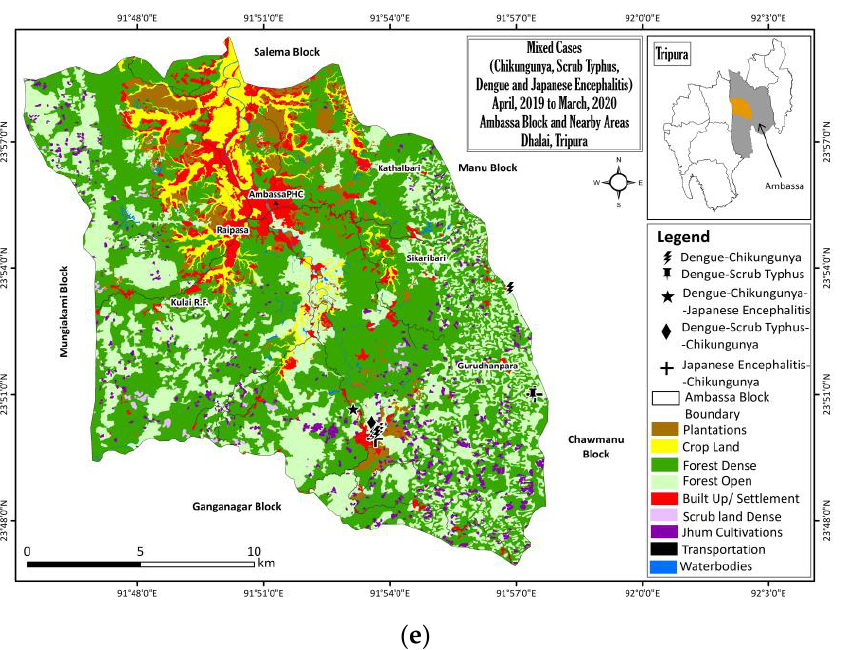
Figure 4. Land Use Land Cover (LULC) Maps of Ambassa Block. LULC mapping was prepared using the orthorectified Indian Remote Sensing satellite data, Cartosat-1 (2.5 m) and LISS-IV (5.8 m), employing on-screen visual interpretation techniques in the GIS platform. Field verifications were made by the project team to check for the accuracy of the interpreted data. Geolocations of village sample collection and NMVBD positive households were collected from the census and plotted on the map for analyses of the proximity of the households to the Jhum fields/plantations/forests, etc. Positive cases found from the PHC IPD collection were plotted for their village address. Geolocations of ( a ) all sample collection households from villages, ( b ) Dengue positive households, ( c ) Chikungunya households, ( d ) Japanese encephalitis and Scrub Typhus households, and ( e ) mixed infection case household locations from village and PHC based surveillance. Maps show the villages located mainly inside or nearby deep forested area with Jhum cultivation.